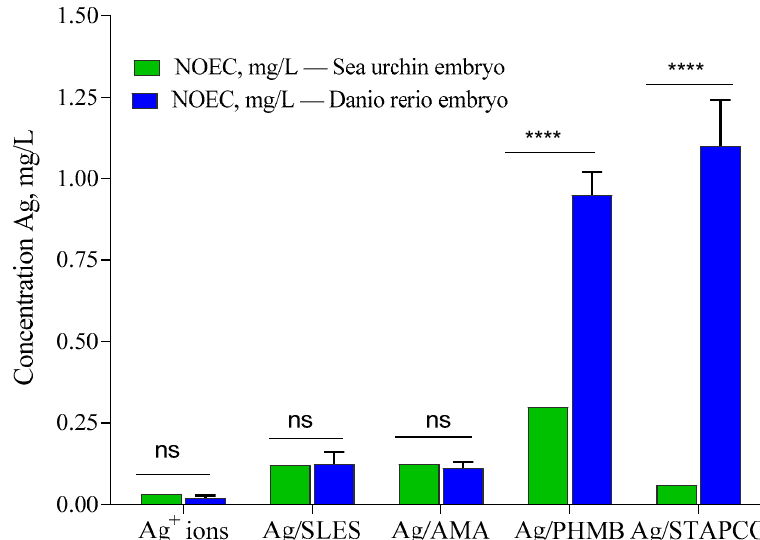
Figure 5. Effects of AgNPs on sea urchin P. lividus and zebrafish Danio rerio embryos. Sea urchin embryos were exposed to AgNPs at the fertilized egg (FE) stage. NOEC: maximal no observed effect concentration (****—statistically significant; ns—statistically not significant).